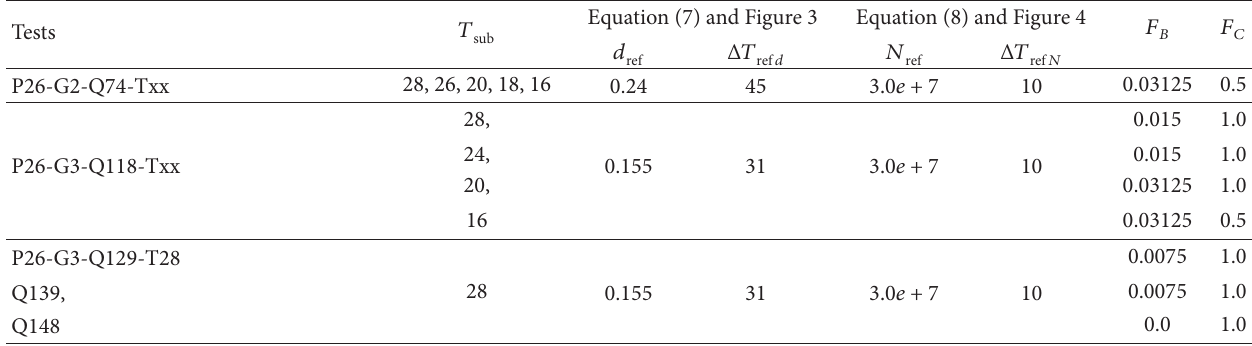
T 4: Adapted parameters for different test